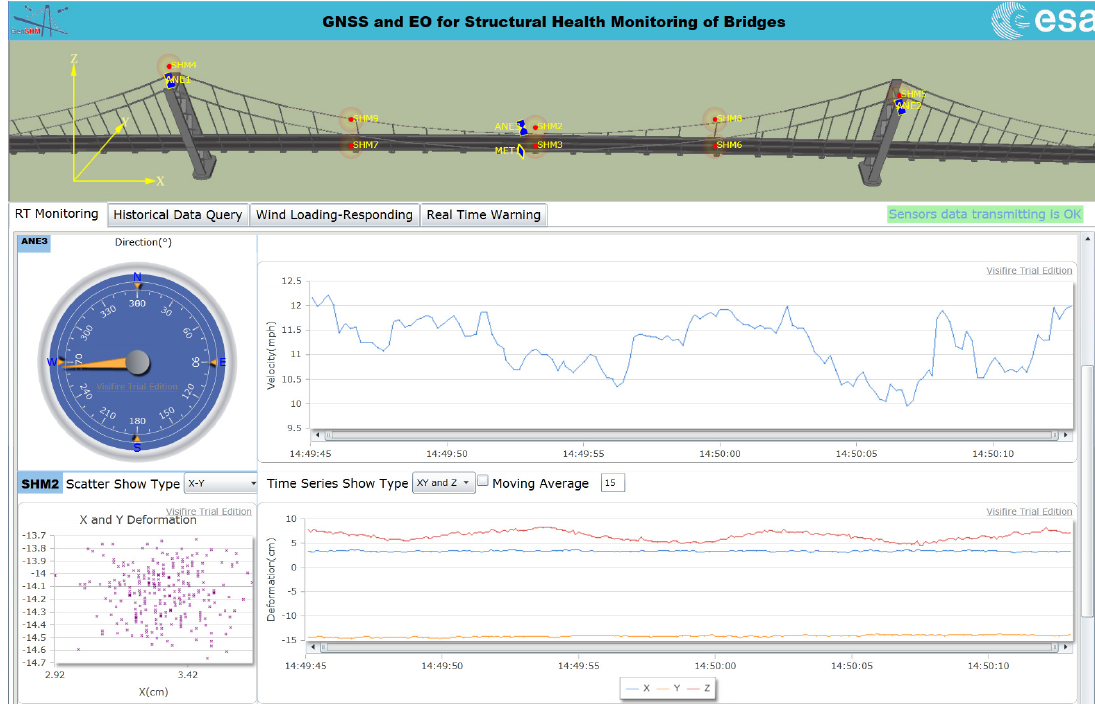
Figure 9. GeoSHM web application.